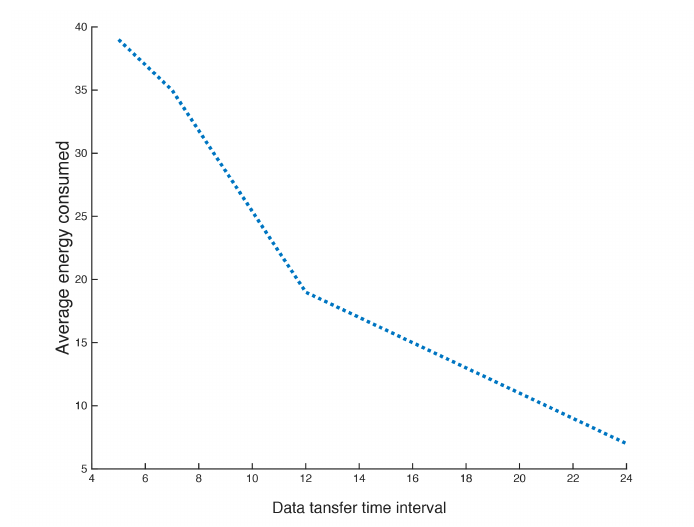
Figure 16. Average power consumption of the level 1 sensor as a function of the transmission interval.